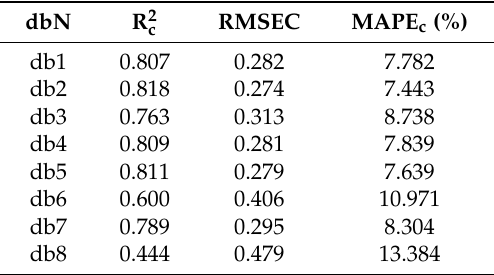
Table 3. Results of PLS model of dbN wavelet family with fifth decomposition level.